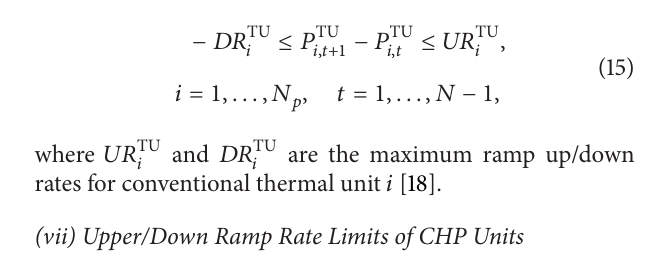
Table 4: Heat load demand of the three-unit system for 24 hours. Time ( h